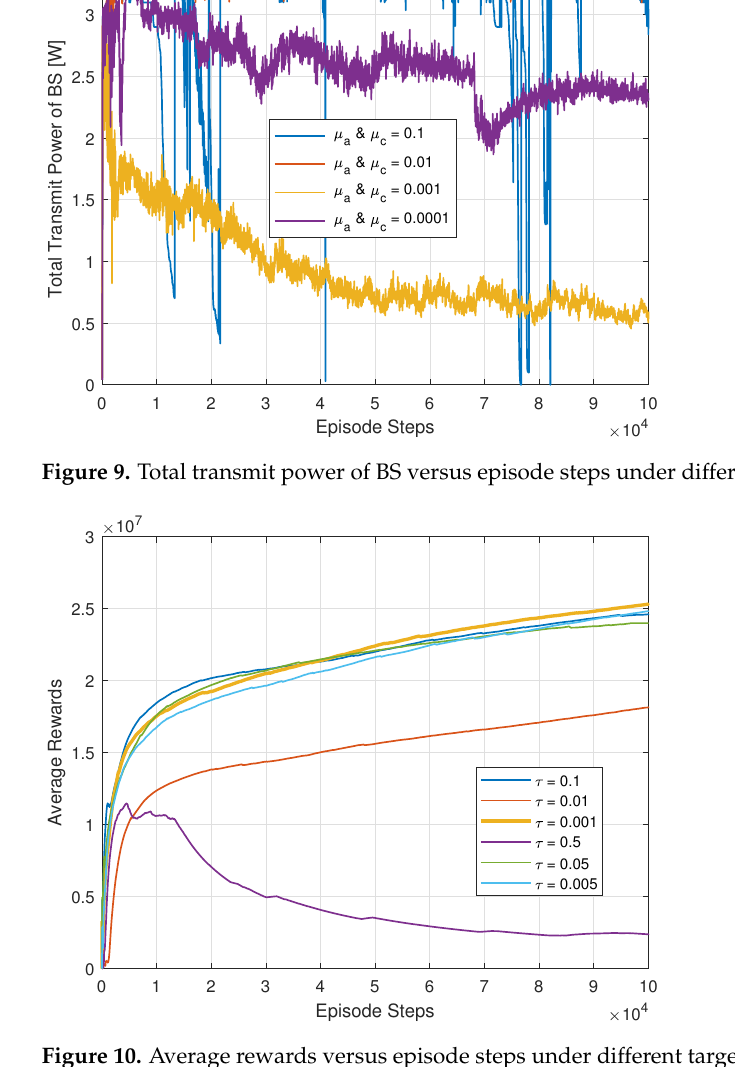
Figure 10. Average rewards versus episode steps under different target smoothing